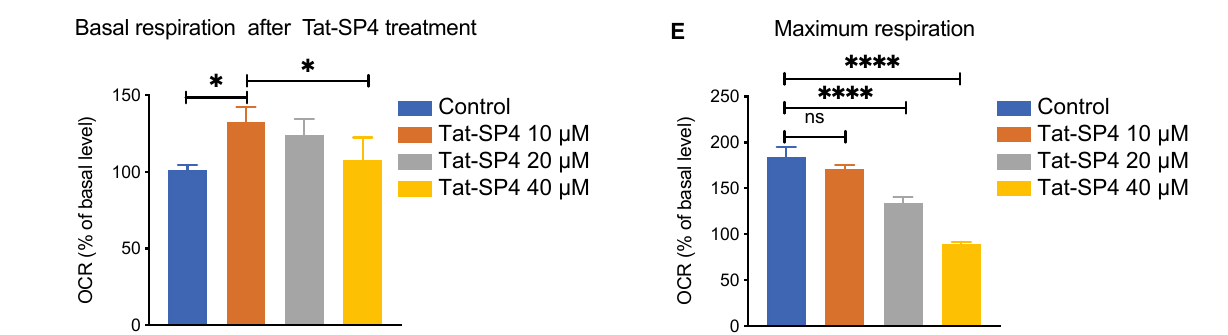
Figure 5. Tat-SP4 impairs mitochondria membrane potential and oxidative phosphorylation activity. ( A ) Representative flow cytometry plot of PDAC cells with the treatment of indicated concentrations of Tat-SP4 for 1 h. Cells were stained with TMRM for 30 min and analyzed in flow cytometry. ( B ) Representative flow cytometry plot of the changes in fluorescence intensity of DCF, an indicator dye of cellular ROS, under the treatment of indicated concentrations of Tat-SP4 for 30 min and 2 h, respectively. Fluorescence intensity is directly proportional to the amount of ROS species in the cell. ( C ) The changes in OCR were measured by Agilent Seahorse Analyzer using Mito Stress Test. BxPC-3 cells were treated with indicated concentrations (10 µ M, 20 µ M, 40 µ M) of Tat-SP4 or vehicle (control) followed by sequential injection of 1 µ M oligomycin, 1 µ M FCCP, and 0.5 µ M rotenone and antimycin A. Each data point represented the relative OCR compared to the base level. Data are presented as mean ± SEM ( n = 5). ( D , E ) Quantification of basal respiration after peptide treatment and maximum respiration changes in ( C ), * p < 0.05, **** p <